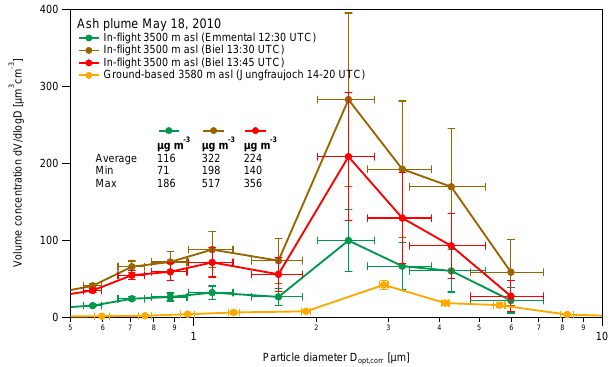
Fig. 12. In-flight volume distributions measured with the DIMO research aircraft over Switzerland on 18 May 2010, during periods with maximal ash concentrations. In addition, retrieved mass con- centration are shown for coarse mode ash particles ( D opt > 1µm), assuming a refractive index of 1.54+0.005i ( λ = 780nm) and a density of 2.65gcm − 3 . For comparison, the maximal volume dis- tribution measured at the Jungfraujoch on the same day is shown. Details on the applied diameter corrections for the two instruments are given in Appendix